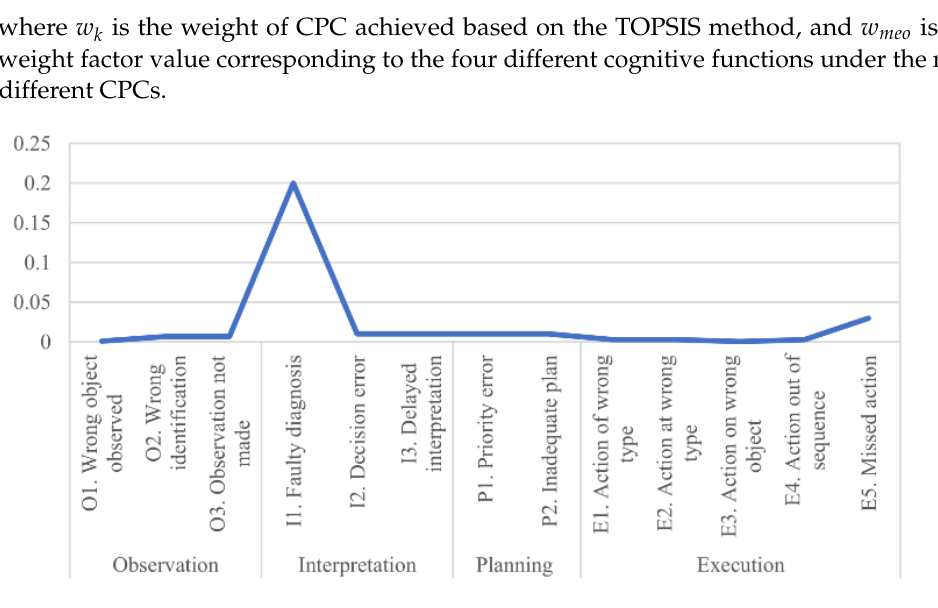
Figure 5. The systemic FRAM model built for the PCR interface operation process.